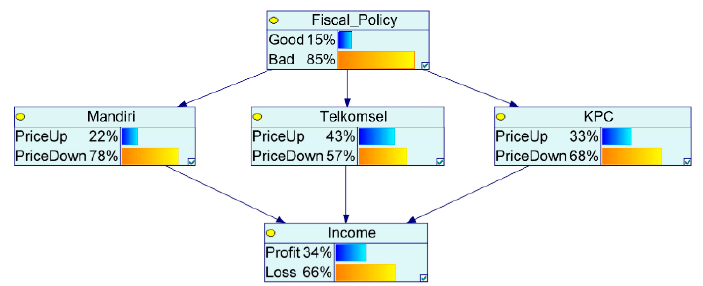
Figure 5. Investment: the result of running the program in the XDSL document.